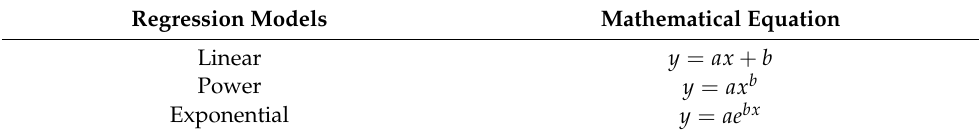
Table 3. The three regression models used in this study. Regression